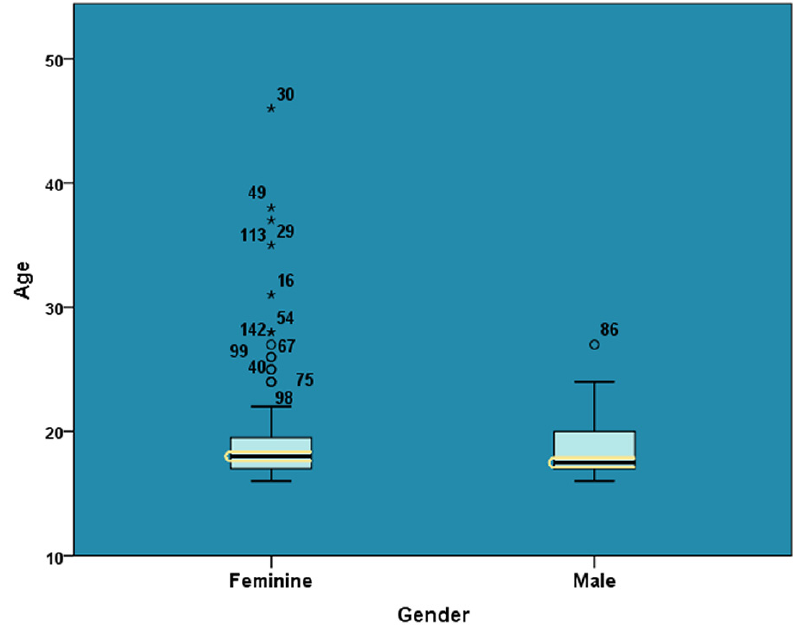
Fig. 3. Gender by age comparison